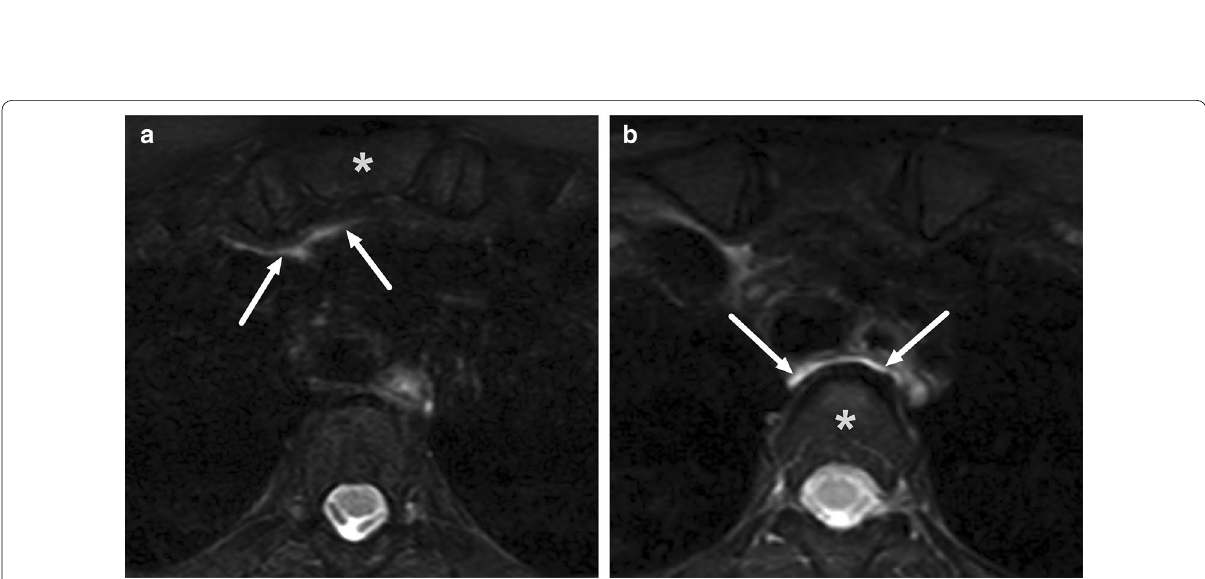
Fig. 10 Examples of ME (arrows) on axial fat-suppressed T2-weighted images in two patients. Anterior ME ( a ) extends to the level of the sternum (asterisk), whereas posterior ME ( b ) is seen at or below the first thoracic vertebra (asterisk, in this patient the third thoracic vertebra). Image modified from ref.